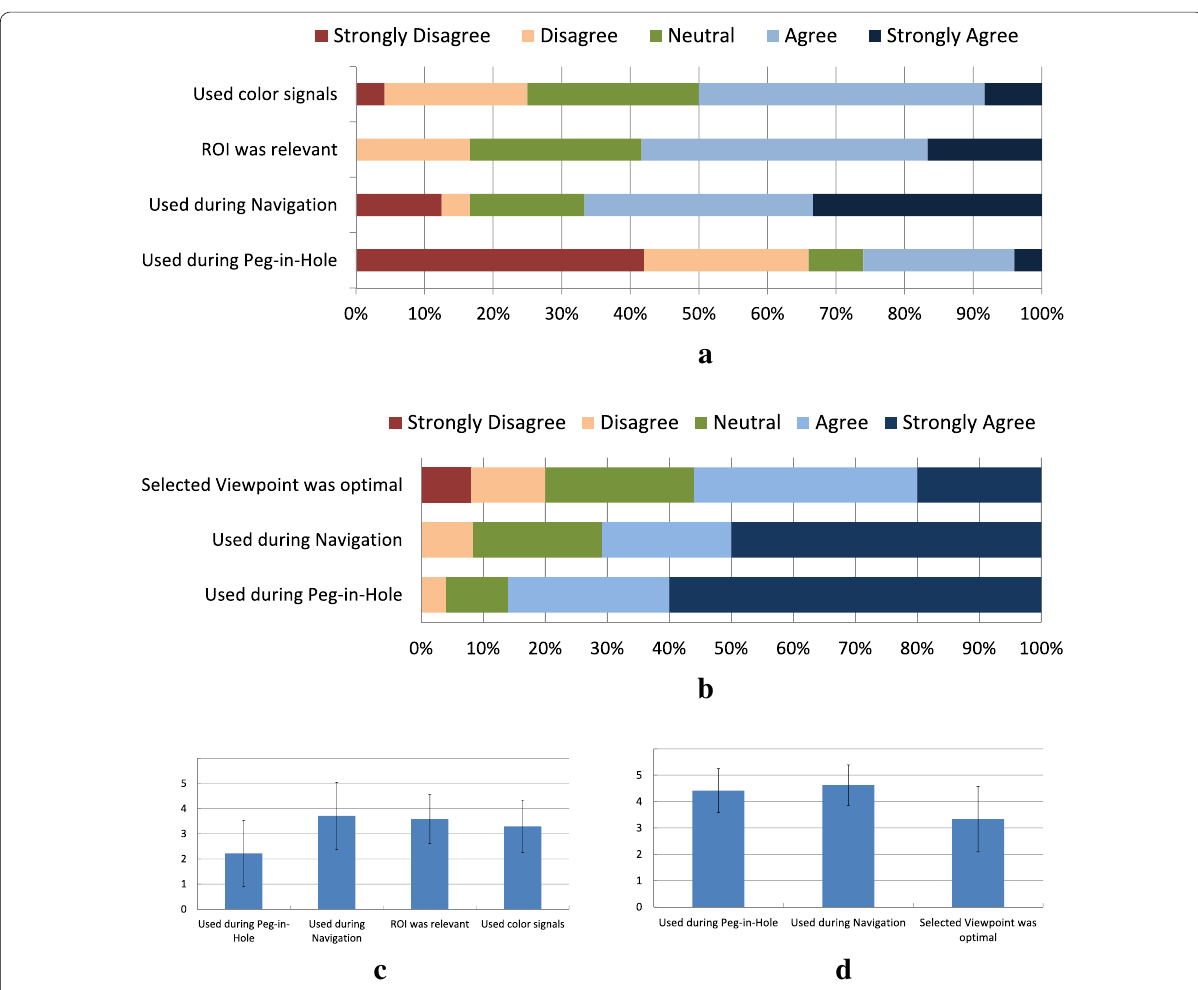
Fig. 19 Survey results on the evaluation of support by wide view and local view monitoring robots. a Response frequency for wide view robot, b response frequency for local view robot, c average score for wide viewrobot, d average score for local